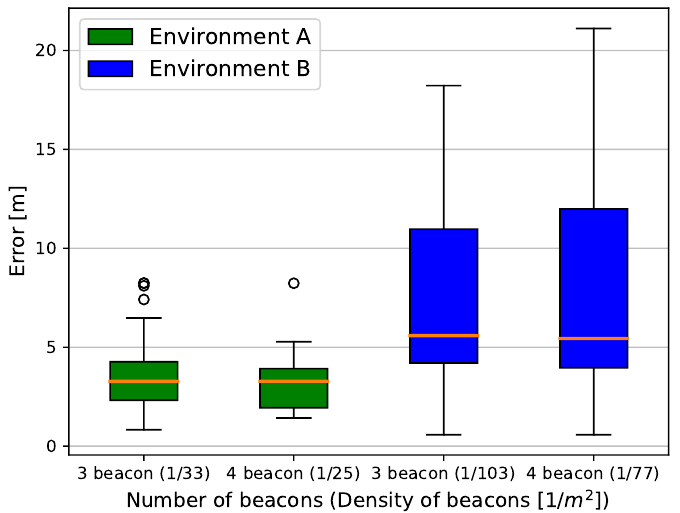
Figure 4. Error box plots for the trilateration algorithm. The x -axis reports the number and the corresponding density of the beacons in the